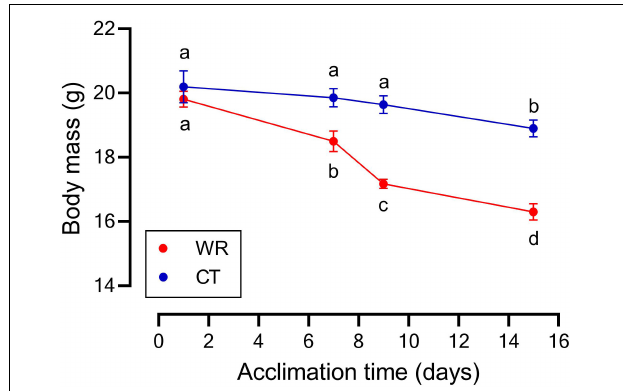
FIGURE 1 | Mean body mass of Z. capensis acclimated to control (CT, n = 9) and water restriction (WR, n = 9) conditions; error bars represent standard deviation. Letters denote significant differences between each treatment at specific time points with a repeated measures ANOVA and posteriori Tukey HSD test.